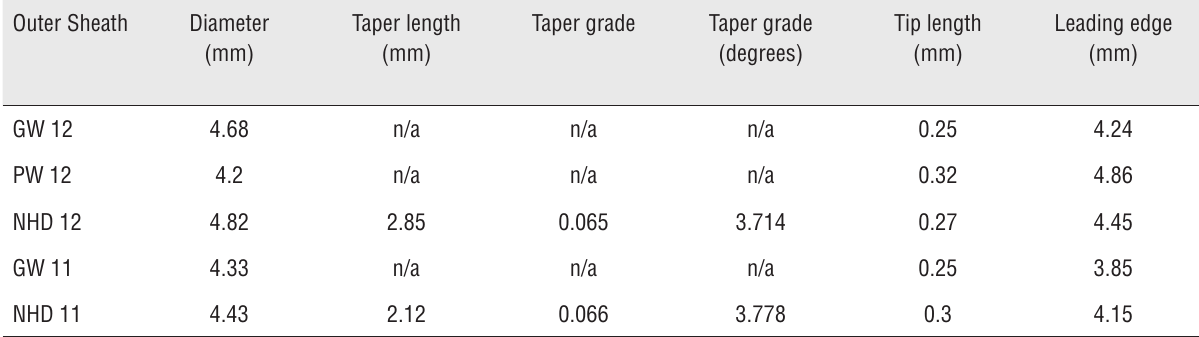
Table 1 - Outer Sheath characteristics. Outer